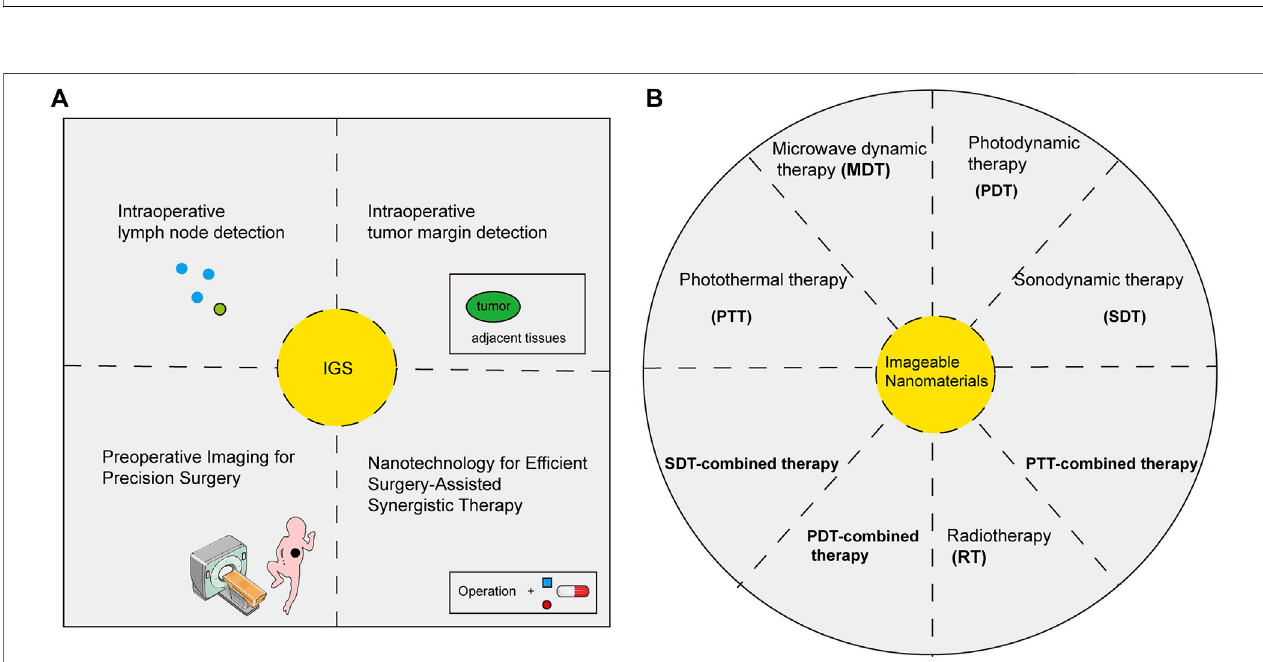
FIGURE 3 | Biomedical applications of imageable nanomaterials in cancers. Imageable nanomaterials were applied in imaging-guided surgery (IGS) (A) and theranostics (B) of cancers.